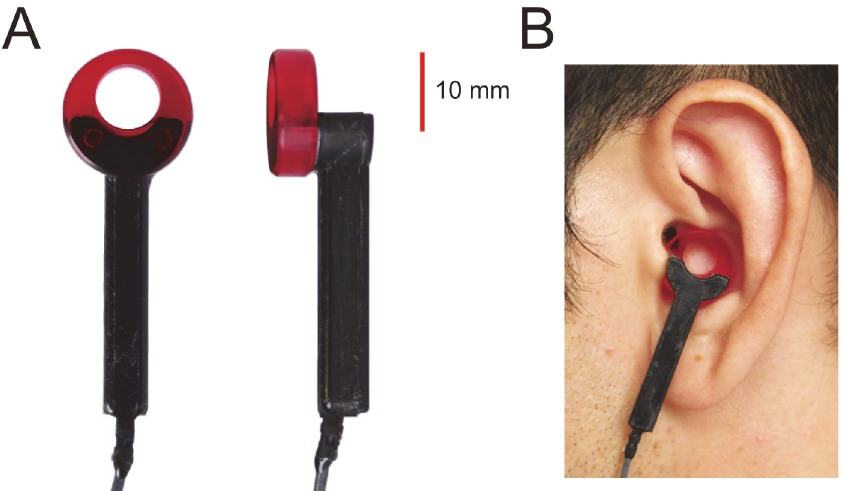
Fig 3. Cartilage conduction transducer. Part A and B show the cartilage conduction transducer and its fixation in the cavity of the